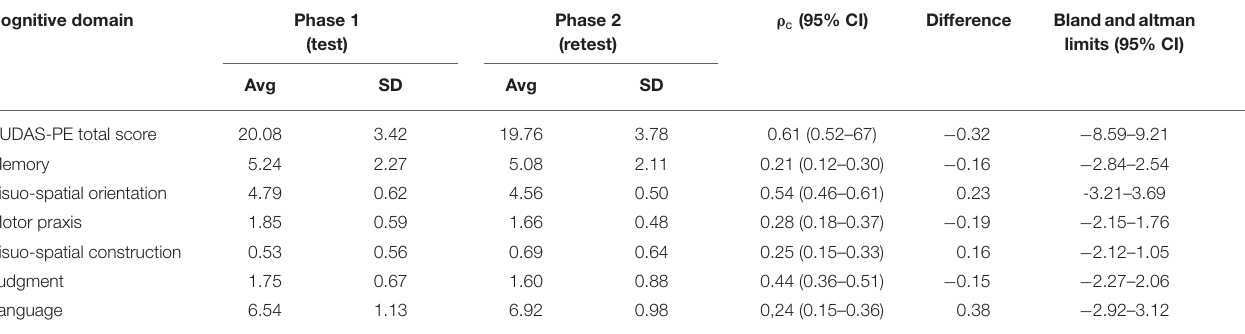
TABLE 2 | Test-Retest Reliability of the Rowland Universal Dementia Assessment Scale (RUDAS-PE). Cognitive